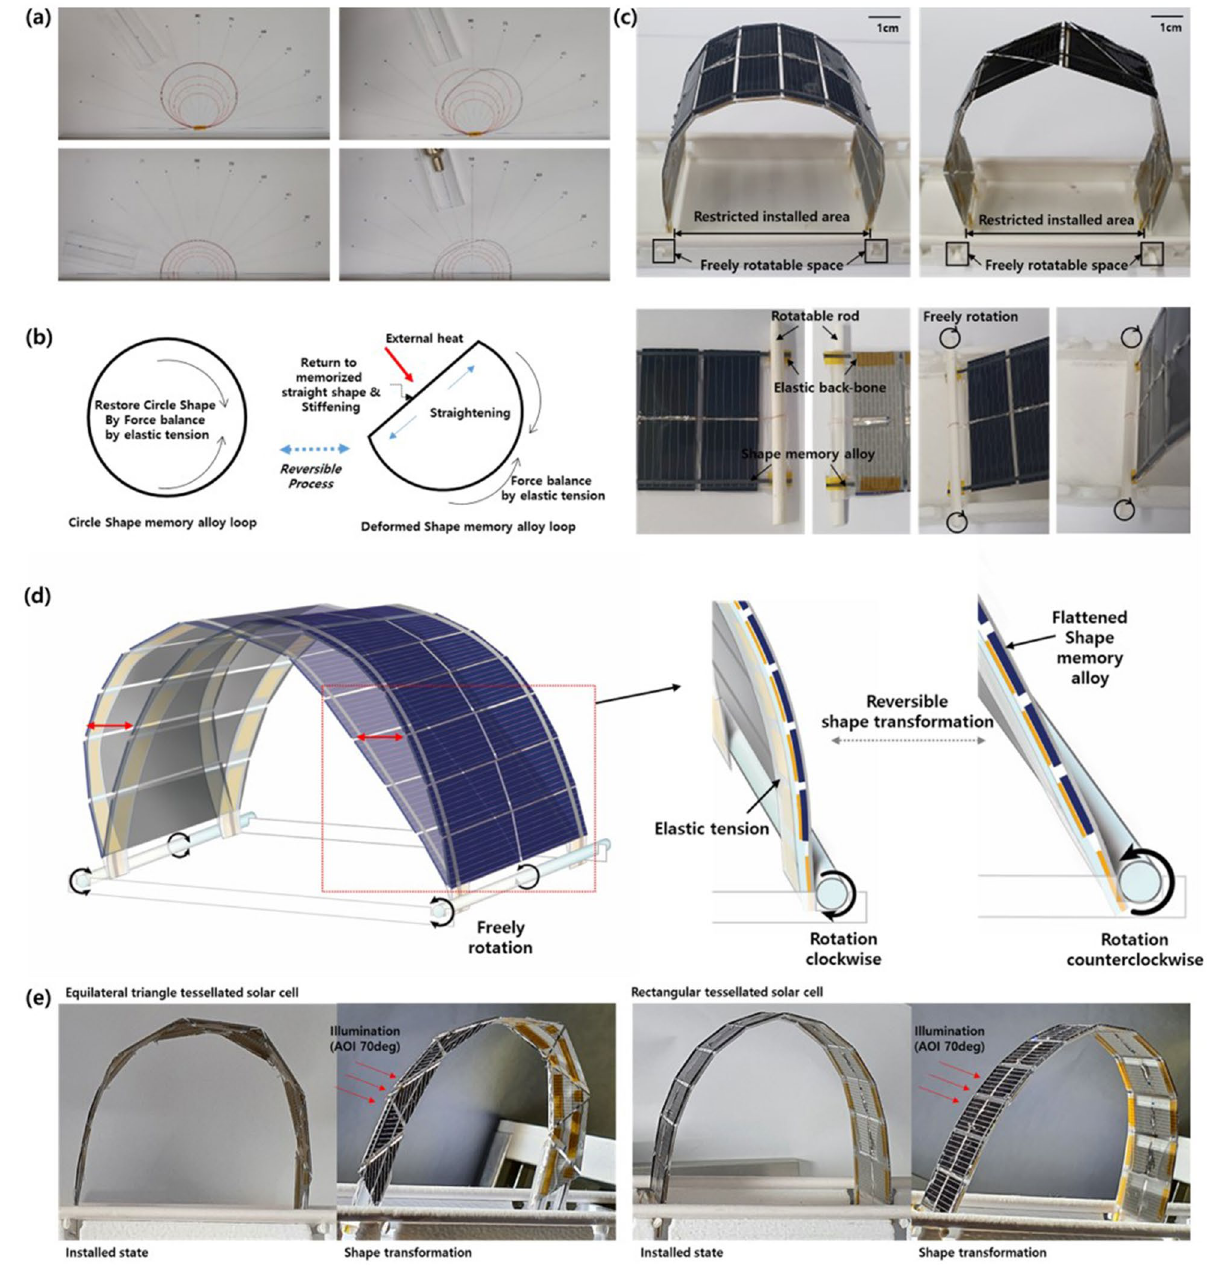
Figure 3. ( a ) Photographs of the wire-type shape-memory-alloy’s shape transformation in response to an external heat source according to the direction of heating, and ( b ) schematic illustration of the transformation mechanism using elastic tension and straightening of the memorized shape of a fixed loop and arch shape. ( c ) Photograph of an installation of rectangular (top left) and right-angled (top right) 2D tessellated solar cells in a restricted area; the front and back sides of the edge part are fixed by a rod (bottom right) to retain the array within a restricted area with free movement (bottom left). ( d ) Schematic illustration of shape transformation within a restricted installation area by free rotation allowing flattening of the surface of the module and recovery to the arch shape by the elastic backbone. ( e ) Photographs of the shape transformation of equilateral-triangle and rectangular tessellated solar cells at an AOI of